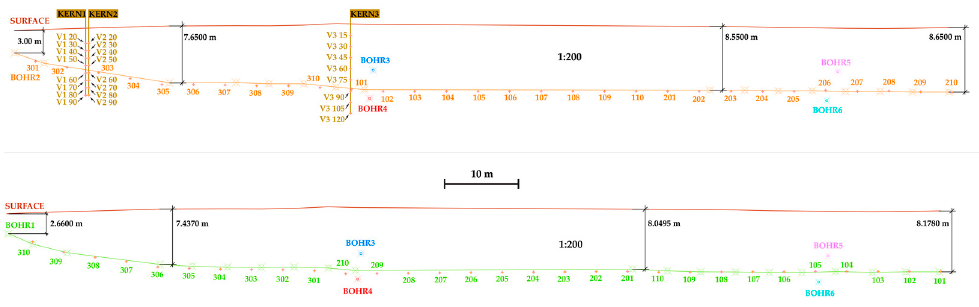
Figure 5. Profiles of BOHR1 and BOHR2 with vertical and horizontal temperature sensors.